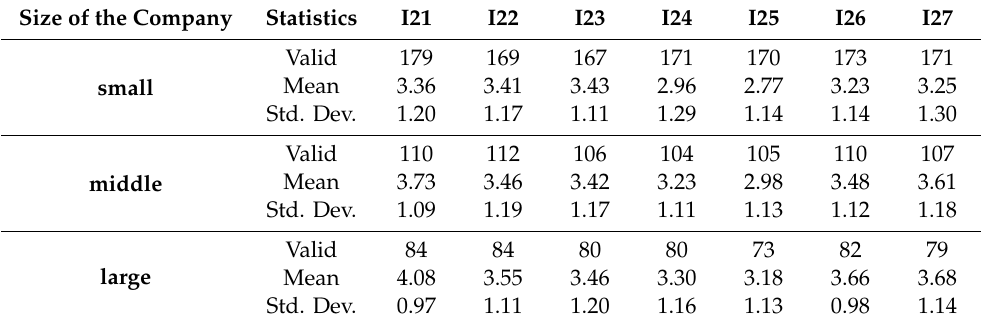
Table 9. Average scores of items in the phase of talent assessment according to size of the company.